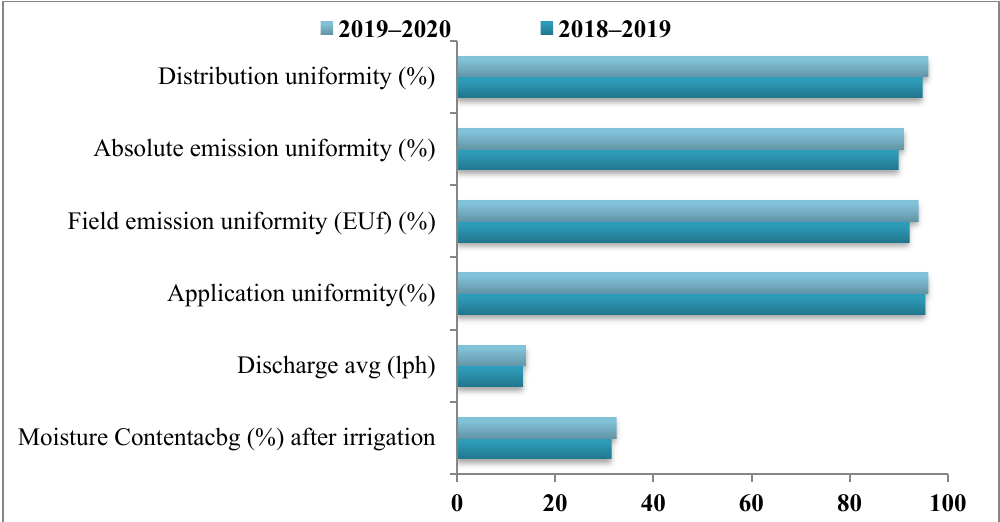
Figure 14. Performance parameters of drip irrigation system.